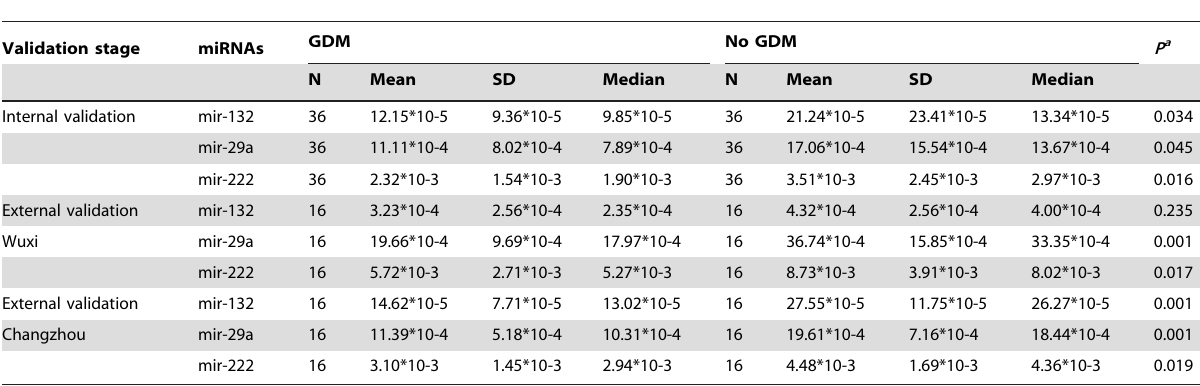
Table 3. Expression of the identified three miRNAs in the validation stages.